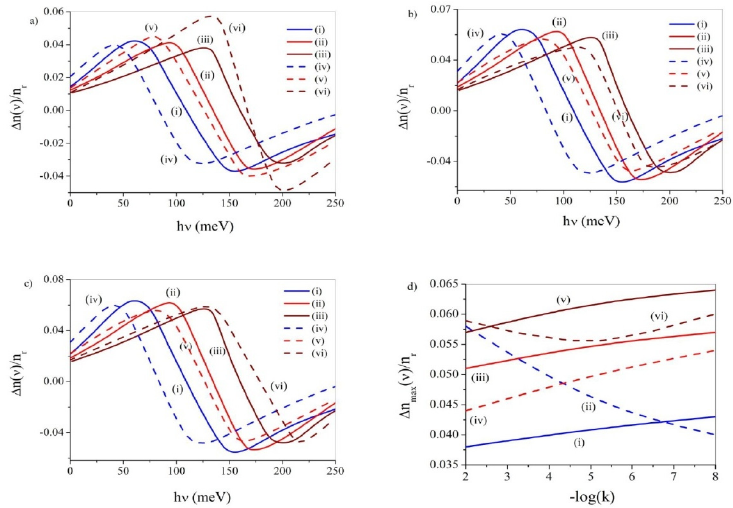
Figure 3. TORIC vs. h υ diagrams ( a ) devoid of noise, ( b ) under ADWN and ( c ) under MLWN. In these diagrams the anharmonicity has (i) odd parity and k = 10 − 8 , (ii) odd parity and k = 10 − 5 , (iii) odd parity and k = 10 − 2 , (iv) even parity and k = 10 − 8 , (v) even parity and k = 10 − 5 , (vi) even parity and k = 10 − 2 . ( d ) Depiction of TORIC peak heights vs. − log(k): (i) devoid of noise and OPA, (ii) devoid of noise and EPA, (iii) with ADWN and OPA, (iv) with ADWN and EPA, (v) with MLWN and OPA and (vi) with MLWN and EPA. In the presence of ADWN, both with OPA and EPA, the TORIC peaks manifest blue- shift and lull in the peak altitude as k enhances. Thus, with ADWN, the parity of the an- harmonic potential does not influence the TORIC profiles as k changes. Moreover, an en- hancement of k is invariably associated with an augmented energy range and a regular loss of overlap between the concerned eigenstates. Under applied MLWN, both with OPA and EPA, the TORIC peaks depict blue-shift as k enhances. However, with OPA, the peak altitude undergoes steady drop as k enhances. On the other hand, with EPA, the peak altitude reveals minimization at k ~10 − 5 . Thus, in this case, both with OPA and EPA the energy separation increases as k enhances. However, whereas the overlap between the eigenfunctions depletes steadily with an increase in k with OPA, under EPA, the said overlap minimizes at k ~10 − 5 . Figure 3d displays the profiles of peak values of TORIC with change in k in the pres- ence and absence of noise, both with OPA and EPA. These diagrams support the obser- vations discussed above. Under odd anharmonic potential the TORIC profiles discern reg- ular rise with fall of k under all conditions. However, under EPA, the said plots divulge regular fall as k decreases in absence of noise, prominent growth with decrease in k under applied ADWN and moderate minimization at k ~10 − 5 under applied MLWN, respectively. Figure 4a,b describes the TORIC diagrams with the change of ( υ ) both under applied ADWN and MLWN for OPA and EPA, respectively, for three different values of ζ viz. 10 − 2 , 10 − 6 and 10 − 10 , for fixed value of k = 10 − 8 . With OPA and under applied ADWN (MLWN) the TORIC peaks display red-shift (blue-shift) coupled with fall in the peak alti- tude as ζ increases. The said pattern reflects depletion (increase) in the energy separation under applied ADWN (MLWN) and a steadfast decline in the overlap between the rele- vant state functions as noise strength is increased.